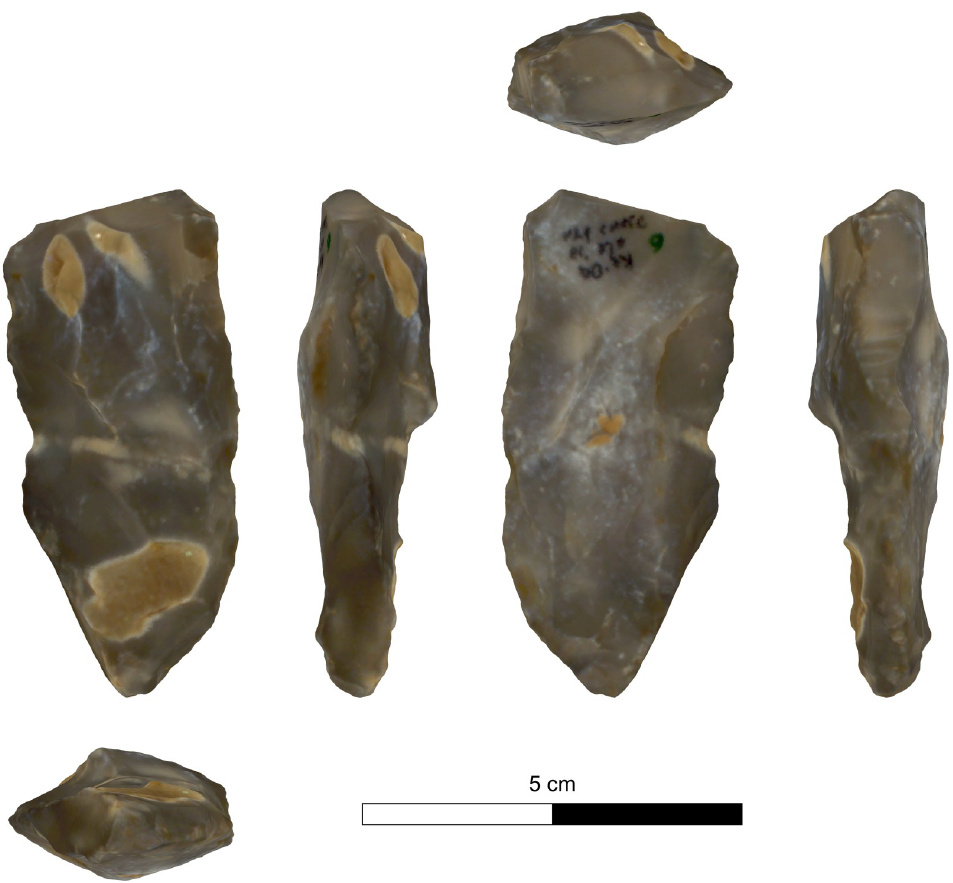
Fig 31. Unfinished biface with preparation for bifacial retouch